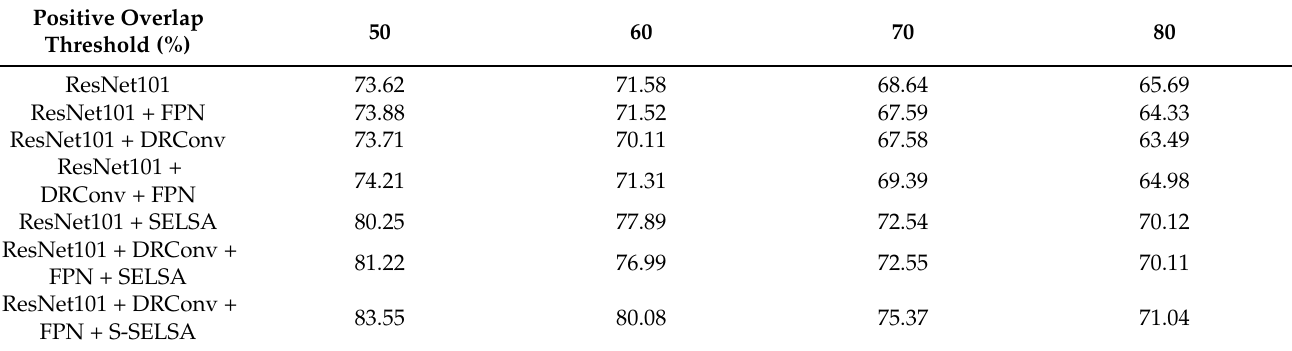
Table 1. Precision of each model with different thresholds.